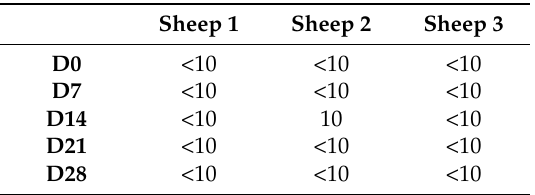
Table 2. Neutralizing antibody titers in sheep experimentally infected with MERS ‐ CoV. Titers were determined by plaque reduction neutralization test (PRNT) using a 90% cutoff.